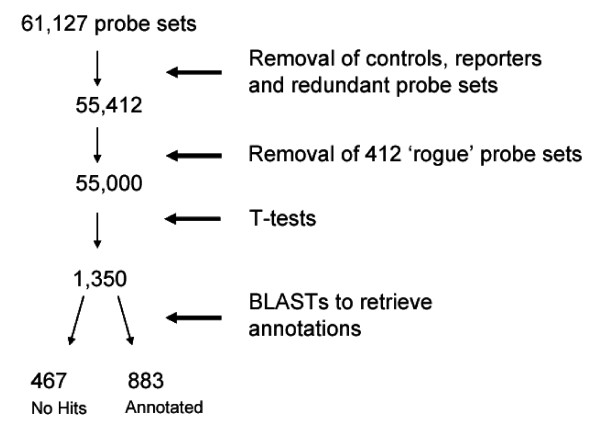
Filtration process used for Affymetrix wheat GeneChip® data. The controls and 'rogue' probe sets were removed from the data prior to filtration. Meiotically-regulated transcripts were then identified using t-tests, with NCBI database annotations retrieved for the remaining transcripts where available (E-value < e-10).